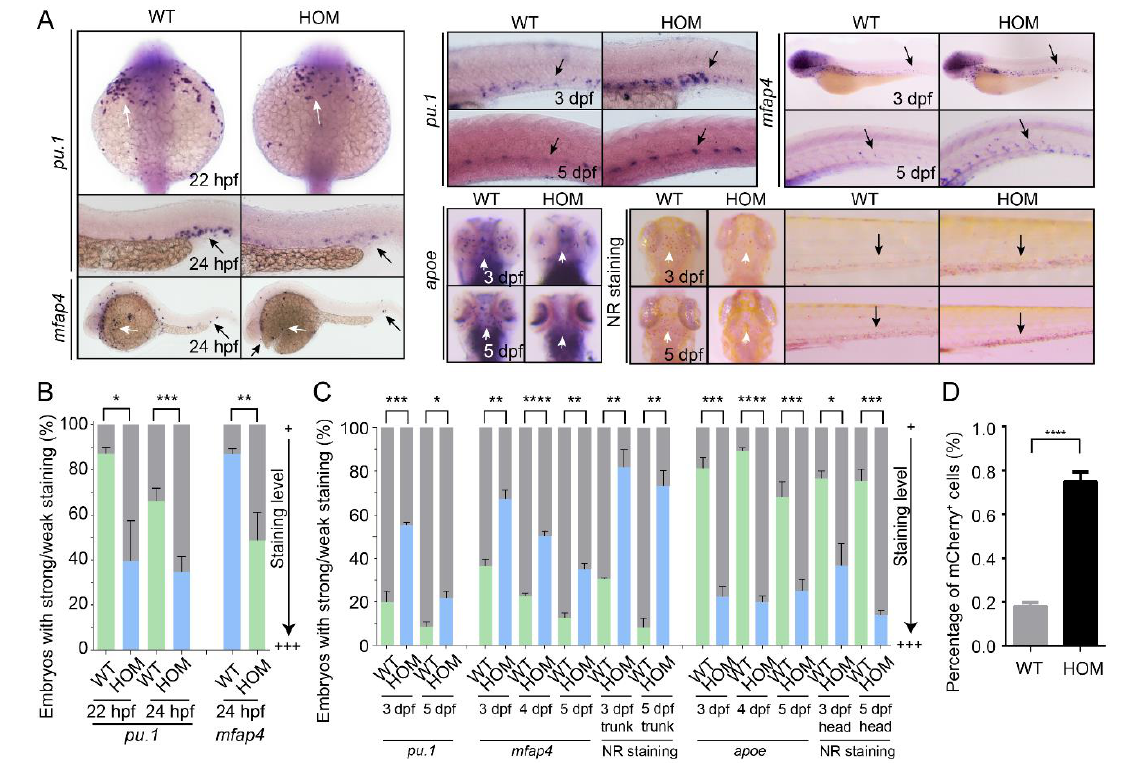
Figure 4. Macrophage development in WT and mafbb mutant embryos. ( A ) WISH of pu.1 , mfap4 and apoe in embryos at 22–24 hpf. WISH of pu.1 , mfap4 and apoe , neutral red (NR) staining in embryos at 3–5 dpf. The white arrows point to the rostral blood island and yolk sac, the black arrows point the ventral tail region. ( B ) Quantification of WISH results in embryos at 22–24 hpf (n = 50–100 embryos per group). ( C ) Quantification of WISH and NR staining in embryos at 3–5 dpf (n = 50–100 embryos per group). ( D ) Quantification of mCherry + macrophage cells from Tg( mpeg1 :mCherry) embryos at 5 dpf by flow cytometry. WT, wild type; HOM, mafbb d 11 /d 11 . Results in B-D are expressed as mean ± SEM, (* p < 0.05, ** p < 0.01, *** p < 0.001, **** p < 0.0001, t test).